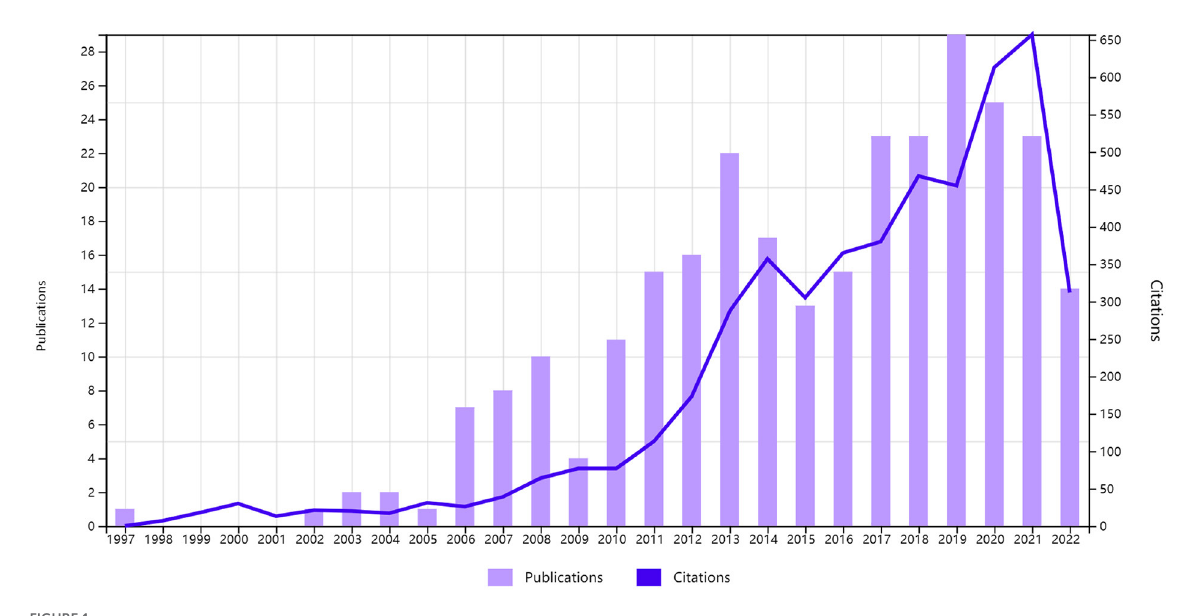
FIGURE1 Annual scientific production and